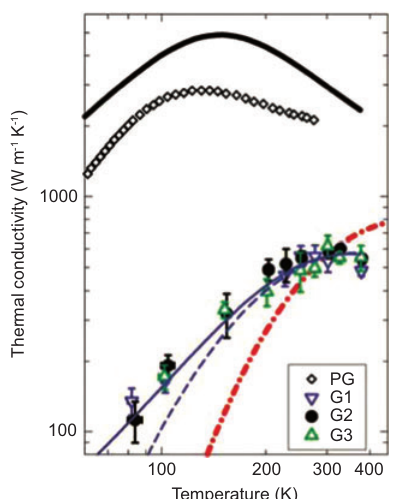
Figure 6 Measured thermal conductivity of G1, G2, and G3 together with the highest reported values of PG (it was a reference number in the literature), the BTE calculation results of suspended SLG (black solid line) and supported SLG with the interface = 0 and K = 0.73 N/m (blue solid line) or force constant K LATA ZA = K = 0.46 N/m (blue dashed line), the RTA calculation K LATA ZA = 0.8 result (red dashed-dotted line) for supported SLG with K LATA N/m. Specular edges are assumed in the calculations. For sup- ported SLG, s = d = 30 nm, and the calculation results are insen- sitive to edge specularity and can be reproduced with decreased d / s and increased K for the same K / K . (Reproduced from ZA LATA ZA Ref. [26] with permission from the American Association for the Advancement of